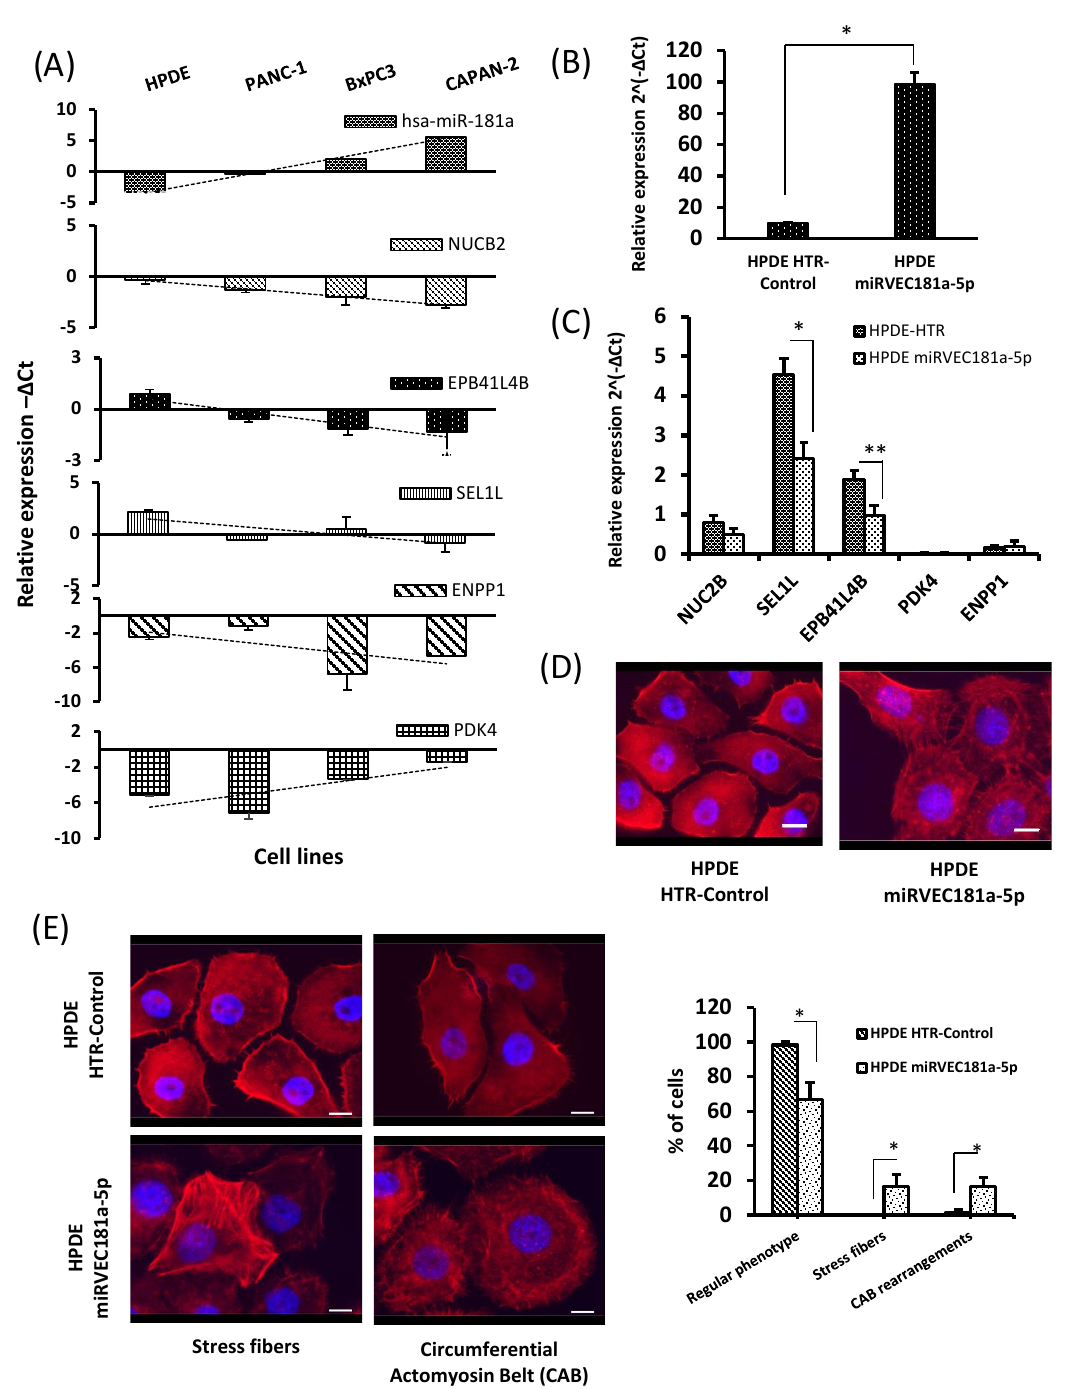
Figure 7. Functional analysis of potential miR-181a targets in pancreatic cellular models. ( A ) Pannel barplot. Expression of miR-181a and its potential targets analysed by qRT-PCR in pancreatic cell lines HPDE, PANC-1, BxPC3, and CAPAN-2. ( B ) qRT-PCR expression of miR-181a in HPDE cell lines transduced with HTR-Control or miRVEC181a-5p, an overexpression model. ( C ) qRT-PCR expression of potential miR-181a targets in HPDE HTR-Control and HPDE miRVEC181a-5p cell lines. ( D ) Representative images of phalloidin-rhodamine staining of HPDE miRVEC181a-5p and HPDE HTR-Control cell lines. Actin filaments are stained in red, nucleus are stained in blue (DAPI). Images are taken at 40 × magnification, scale bar 100 µ m. ( E ) The representative images of cells showing regular phenotype, stress fibres, or circumferential actomyosin belt (CAB) rearrangements in HPDE HTR-Control and HPDE miRVEC181a-5p cell lines (left) and cell quantification (right). The data of n = 3 independent experiments. p value < 0.05 (*), p value <